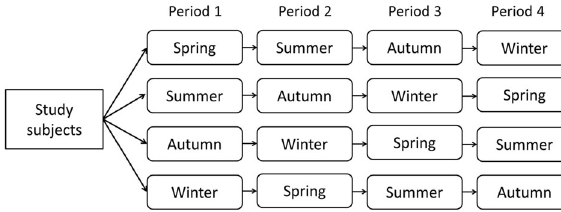
Fig. 2 Relationships between the season of birth and the time sequence. Period 1 was de fi ned as the season of birth. Period N of a measurement was de fi ned as the number of seasons subsequent to the season of birth within which the measurement was made. The multilevel linear regression analysis was conducted as a crossover randomized control trial-like method with fi tting the time sequence as a random